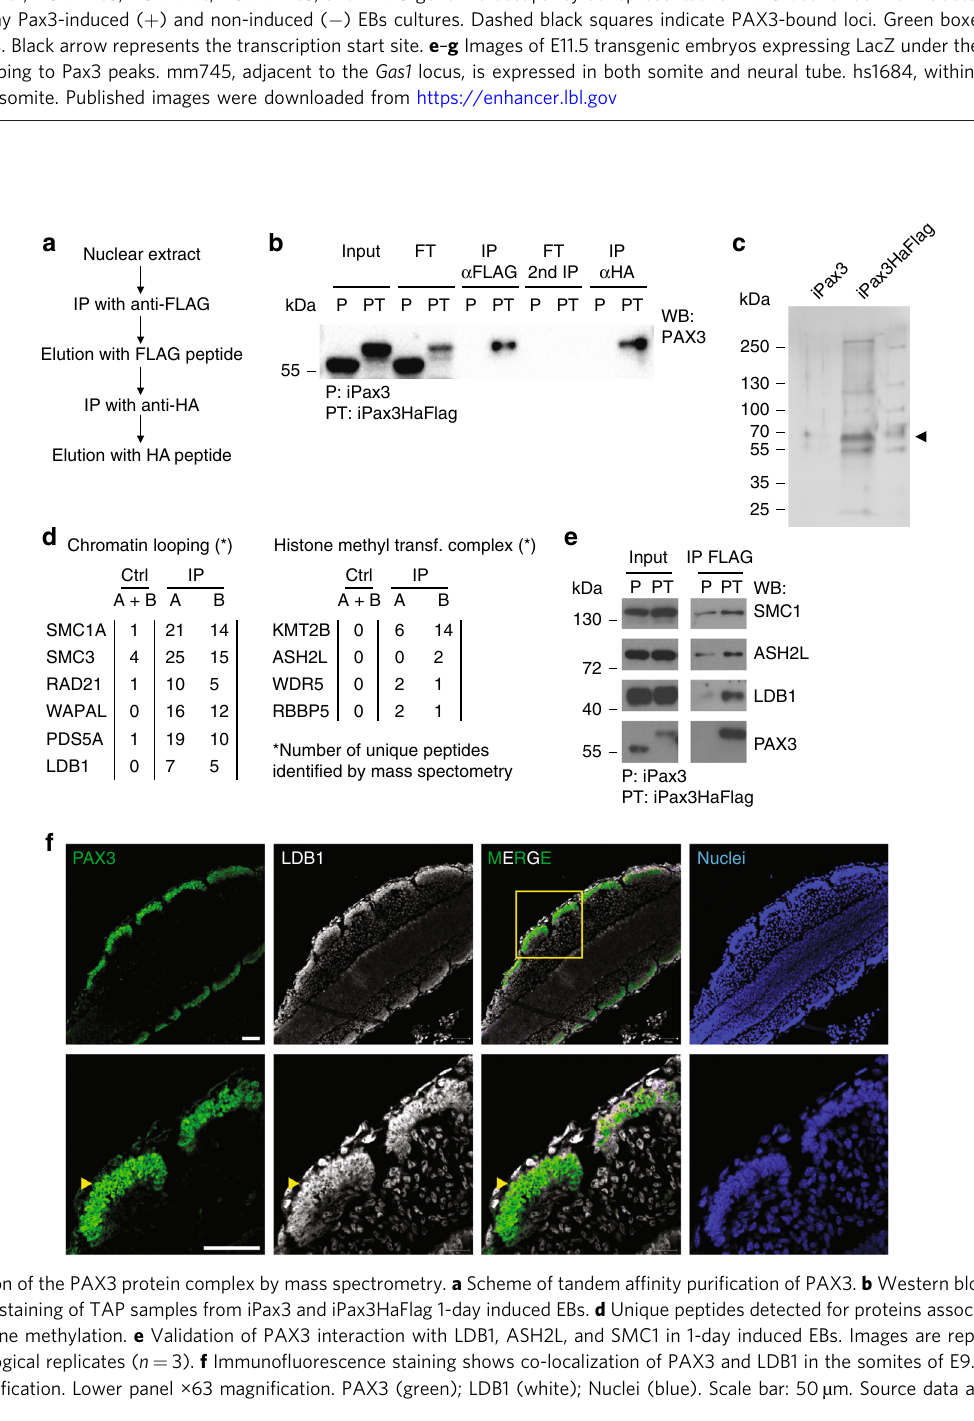
Fig. 2 Epigenetic reprogramming of PAX3 binding sites. a HiChIP normalized matrix from 6-day Pax3-induced cells displaying the Myf5 locus shows that the region characterizing increased contacts (triangle) undergoes changes in deposition of H3K4me1 and H3K27Ac marks over time. Scale: maxrange = 0.2. IGV snapshot displaying the ChIP-seq tracks for H3K27Ac, H3K27me3, H3K4me3, and H3K4me1 in non-induced, 1-day and 6-day induced iPax3 cells is shown below. Green boxes represent intergenic regions. Black arrow represents the transcription start site. b k-means clustering of H3K4me1, H3K4me3, H3K27me3, and H3K27Ac ChIP-seq data from 1-day Pax3-induced ( + ) and non-induced ( − ) EB cultures. Mapped data were used to generate a Density Tag Map centered on 3780 PAX3 peaks ±3 kb. Cluster 1: 960 peaks; Cluster 2: 566 peaks; Cluster 3: 136 peaks; Cluster 4: 2122 peaks. c Distribution of H3K4me1, H3K4me3, H3K27me3, and H3K27Ac ChIP-seq reads across the PAX3 peak center ±3 kb for clusters 1 and 4 shown in panel b . d – f IGV track displaying H3K4me1, H3K4me3, H3K27Ac, H3K27me3, and PAX3 genomic occupancy at representative PAX3-bound loci from clusters 1 ( Gas1 ) and 4 ( Adamts5 ) in 1-day Pax3-induced ( + ) and non-induced ( − ) EBs cultures. Dashed black squares indicate PAX3-bound loci. Green boxes represent intergenic regions. Black arrow represents the transcription start site. e – g Images of E11.5 transgenic embryos expressing LacZ under the control of VISTA elements overlapping to Pax3 peaks. mm745, adjacent to the Gas1 locus, is expressed in both somite and neural tube. hs1684, within Adamts5 gene, is expressed in the somite. Published images were downloaded from https://enhancer.lbl.gov